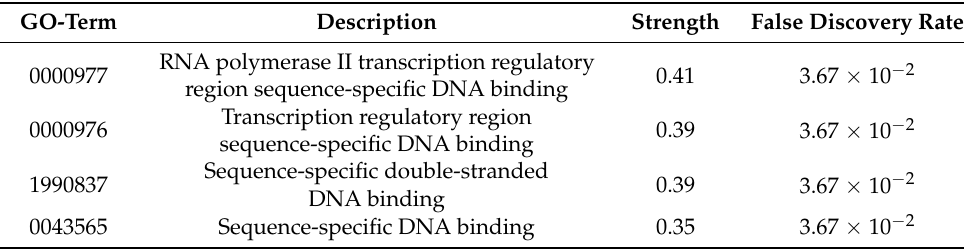
Table 1. The GO enrichment results of differentially methylated genes related to aging (based on SIMPO algorithm).